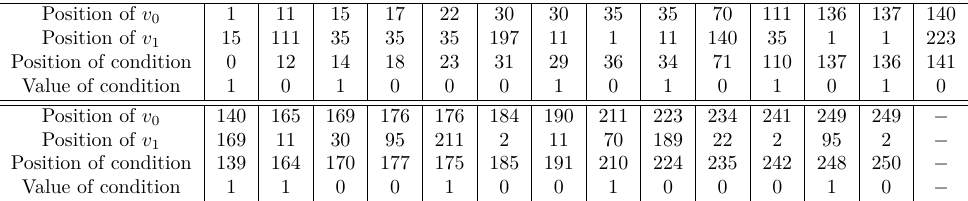
Table 8: Parameters for TYPE-III conditional cube tester